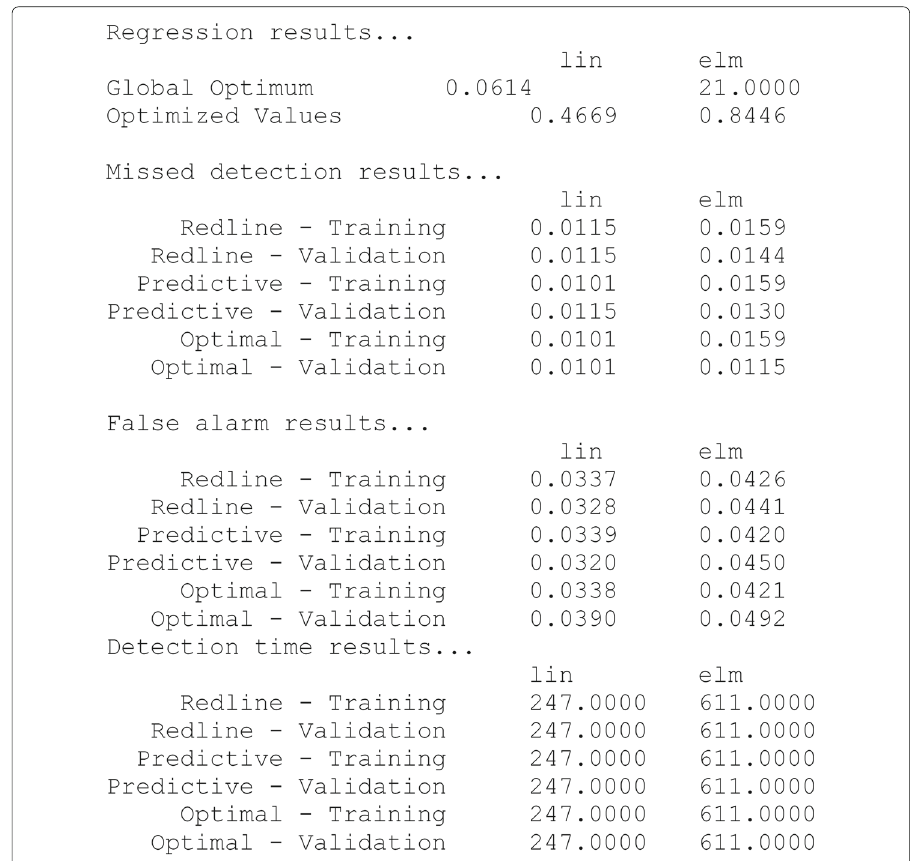
Fig. 8 ACCEPT results on MDR, FAR and DT for fault case “ventilation fails”. Regularization coefficient is 0.0614 and number of hidden neurons is 21. Missed Detection Rate (MDR) is shown first, then False Alarm Rate (FAR) and finally Detection Time